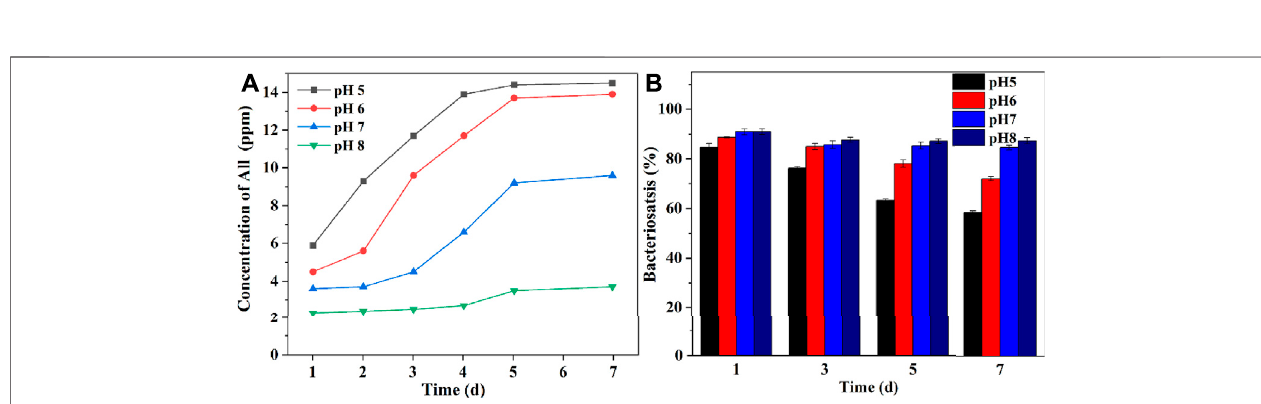
FIGURE10| ConcentrationofALLreleasedfromthePDA/TA-ALL@CS-7coatingsindifferentpHPBSsolutions (A) .ThebacteriostasisofthePDA/TA-ALL@CS-7 coatings against P. aeruginosa after being immersed in different pH PBS solutions for seven days (B) .